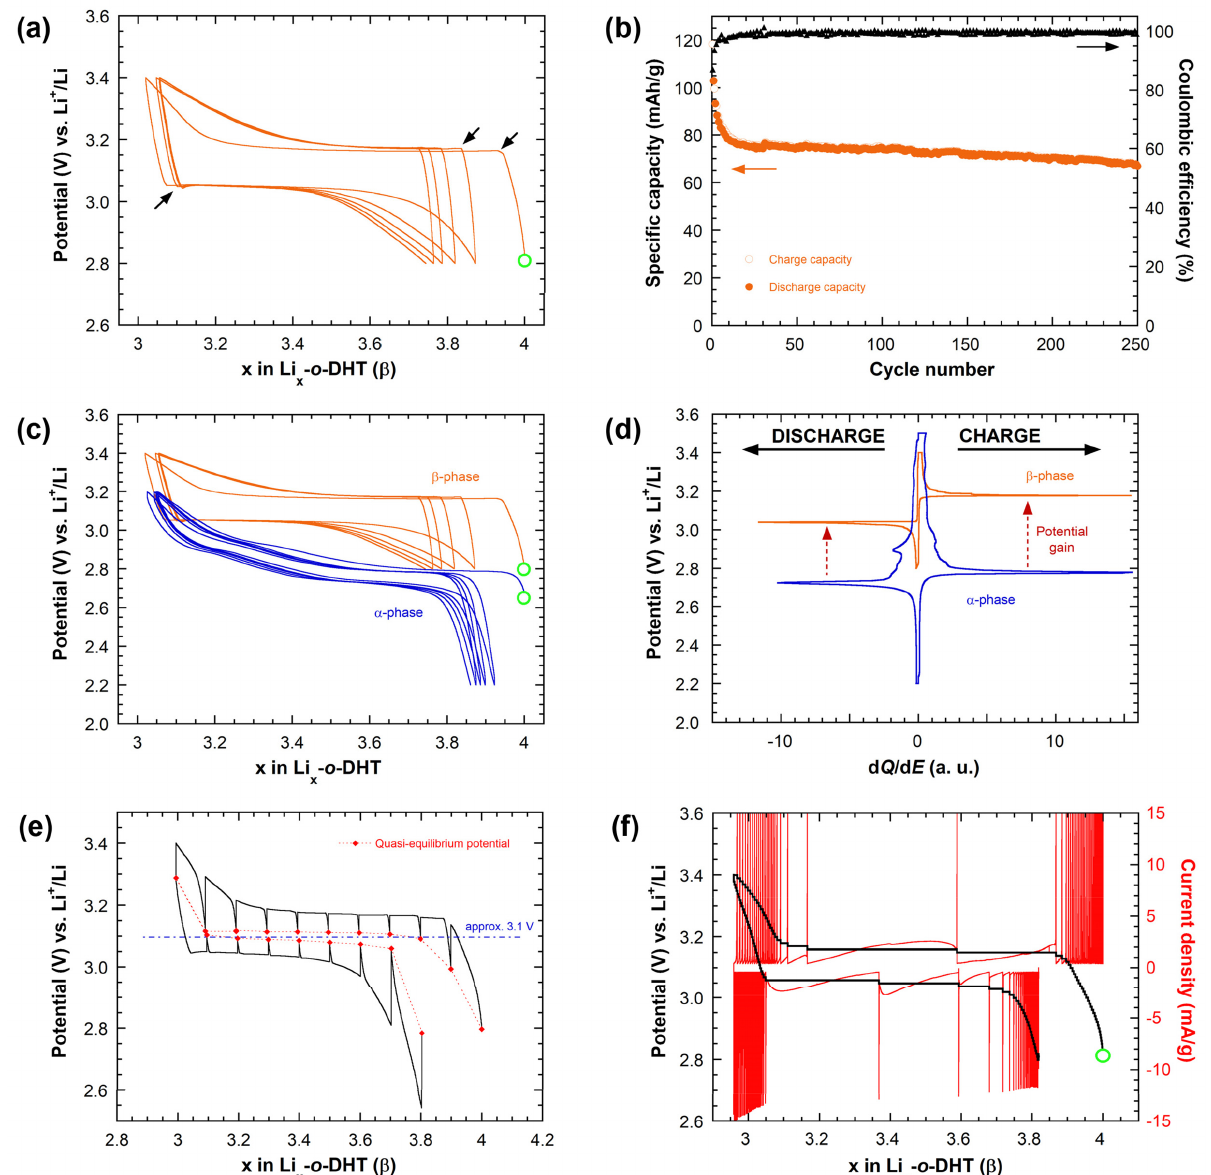
Figure 6. ( a ) First five cycles of a Li half-cell using Li 4 -o-DHT ( β -phase) as the positive electrode material (carbon additive: 33 wt% KB600) galvanostatically cycled at 1 Li + /10 h ( I = 10.5 mA.g − 1 ). Arrows highlight the overpotential activation peaks at the beginning of each two-phase transition. ( b ) Corresponding capacity retention curve (in orange), together with the coulombic efficiency (in black). ( c ) Superimposition of the potential-composition curves for the two polymorphs using the published data for the α -phase (adapted with permission from [21]. Copyright 2014 American Chemical Society). ( d ) Corresponding potential vs. differential capacity curves (first cycle). The red arrow marks the positive potential shift. ( e ) Potential-composition curve for a Li half-cell using Li 4 -o-DHT ( β -phase) as the positive electrode material (carbon additive: 33 wt% KB600) cycled in GITT mode at 1 Li + /10 h for ∆ x = 0.1 followed by a relaxation period of 48 h. ( f ) PITT curves for a similar cell using potential steps of ∆ E = 10 mV with a current limit corresponding to a rate of 1 Li + /300 h (I min = 0.4 mA.g − 1 ). [Electrolyte: 1 M LiClO 4 /PC; the green circle indicates the starting potential].